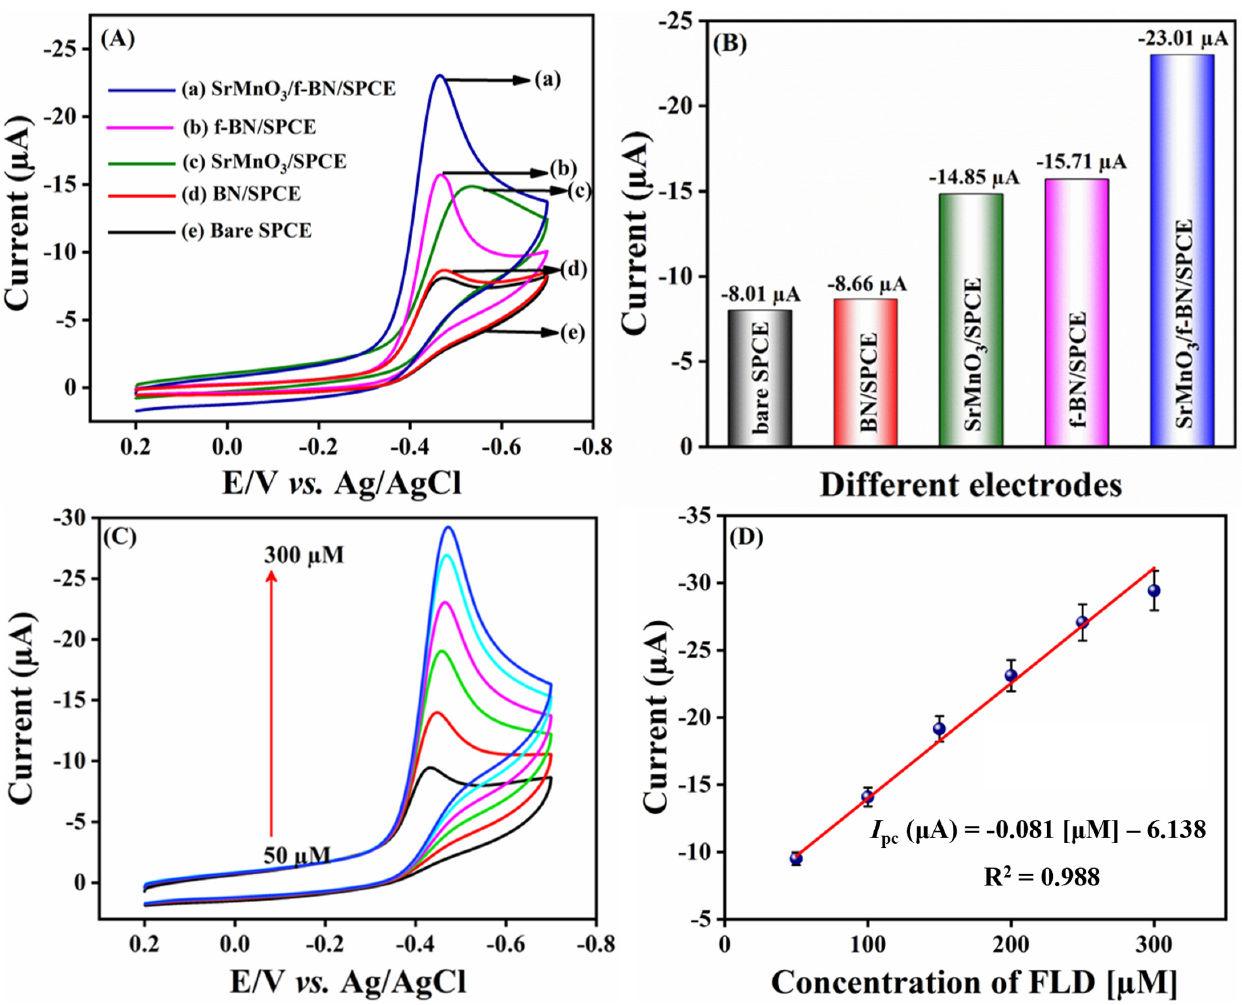
Figure 4. ( A ) CVs of different modified SPCE of FLD detection in 0.1 M PBS (pH 7) with 200.0 µM of FLD; scan rate 50 mV/s. ( B ) Bar diagram of different electrodes vs. current (µA). ( C ) CVs for